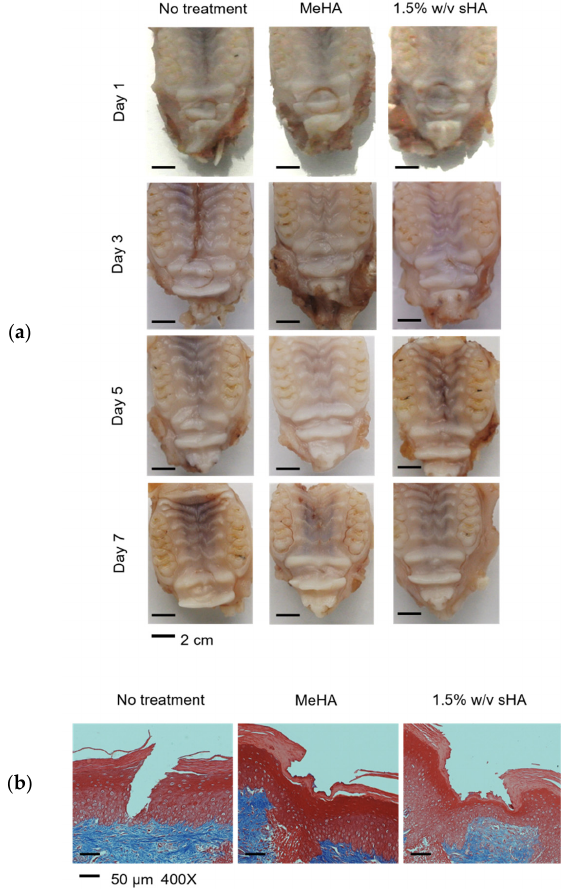
Figure 6. The physical appearance of the wounds on the rats’ palates in three groups of intervention at each time point, with scale bars of 2 cm ( a ). ( b ) shows the histological sections of the rodents palates, staining with hematoxylin and eosin (H&E) after 1 day of treatment, with 50 µm scale bars of 400× magnification.